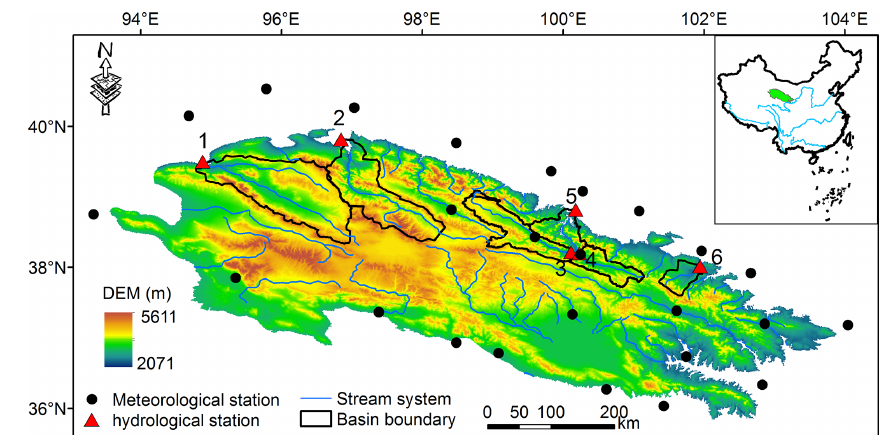
Figure 1. The six basins in China’s northern Qilian Mountains. The Digital elevation data, at 30m resolution, were provided by the Geospatial Data Cloud site, Computer Network Information Center, Chinese Academy of